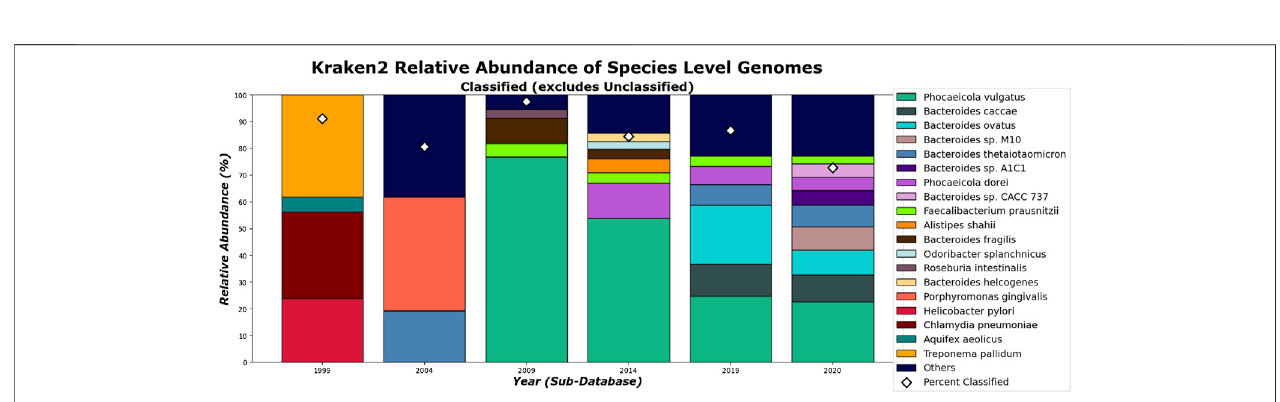
FIGURE15| Kraken2 ’ srelativeabundanceforSpecieslevel.Onlytaxawhoseclassi fi edrelativeabundancewasatleast3%areshownasacoloredbarhere.Only bars for the classi fi ed reads are included. The percentage of classi fi ed reads traced back to species level for each year are shown as diamond markers.